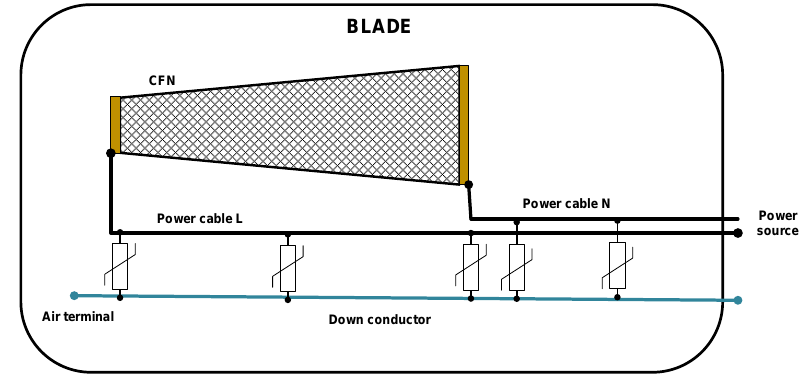
Figure 10. Optimized SPD installation scheme.